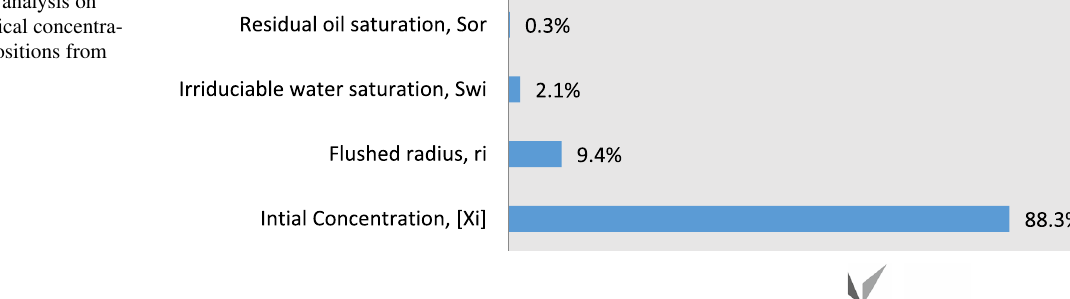
Fig. 4 Sensitivity analysis on the injected chemical concentra- tion at different positions from the